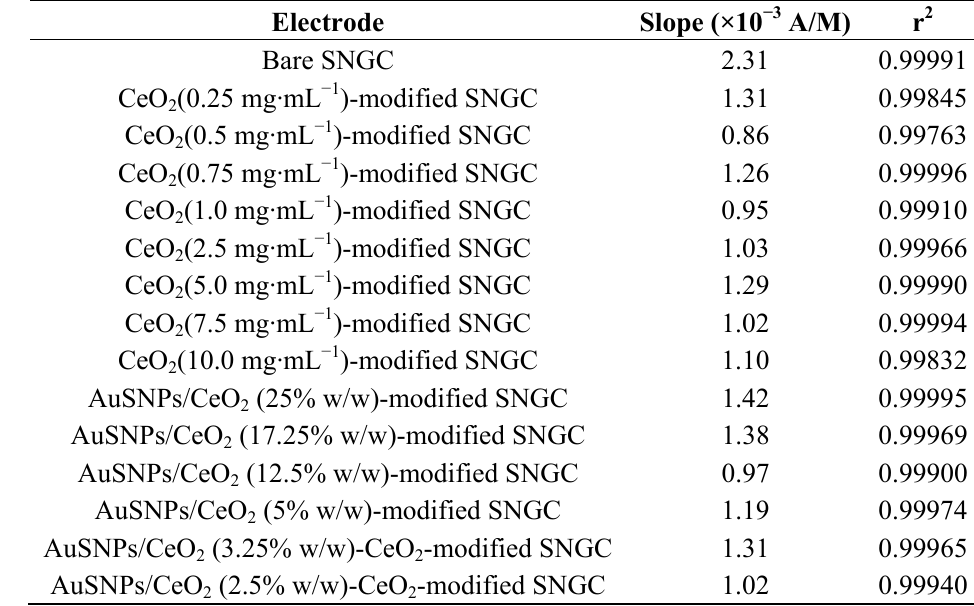
Table 2. Results of the calibration curves obtained for AA when using the different types of Sonogel-Carbon electrodes